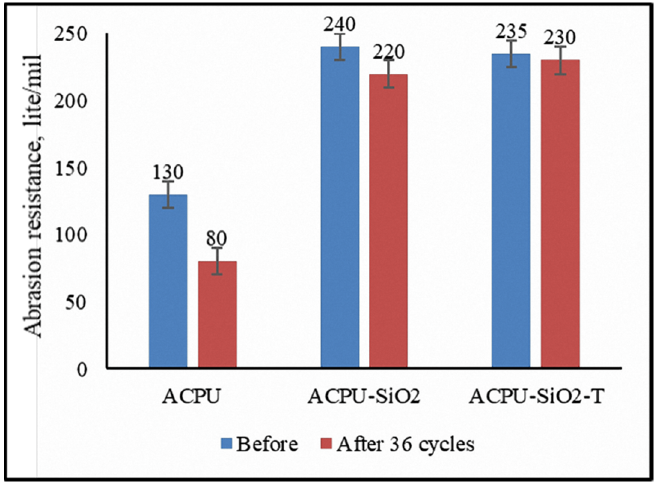
Figure 8. Values of abrasion resistance for coatings, before and after 36 cycles of aging.